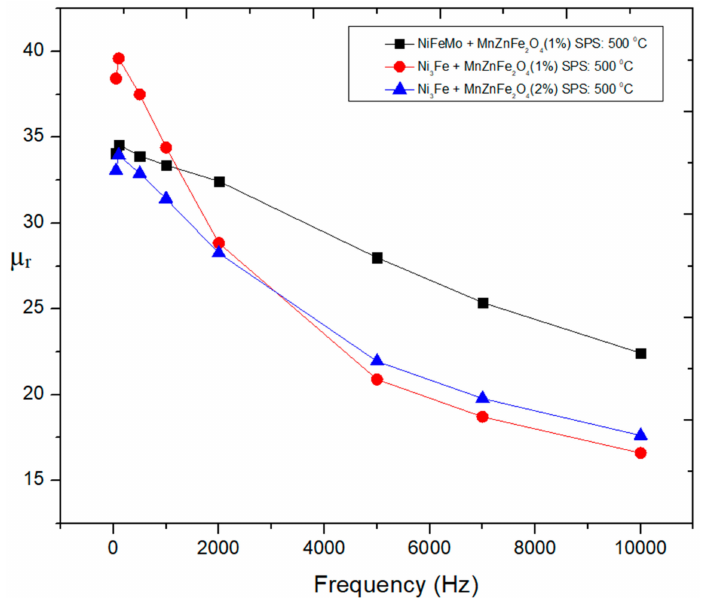
Figure 14. Evolution of initial magnetic permeability as a function of the frequency for toroidal- shaped (Ni 3 Fe, supermalloy)/Mn 0.5 Zn 0.5 Fe 2 O 4 composite compacts, SPS-ed at the sintering tempera- ture of 500 ◦ C. The induction level was set at 0.01 T.